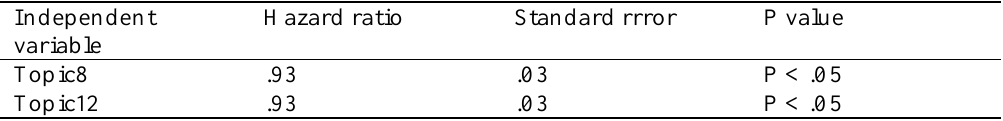
Hazard Ratios for Two Different Subcommunity Topics in the Accountable Talk Course